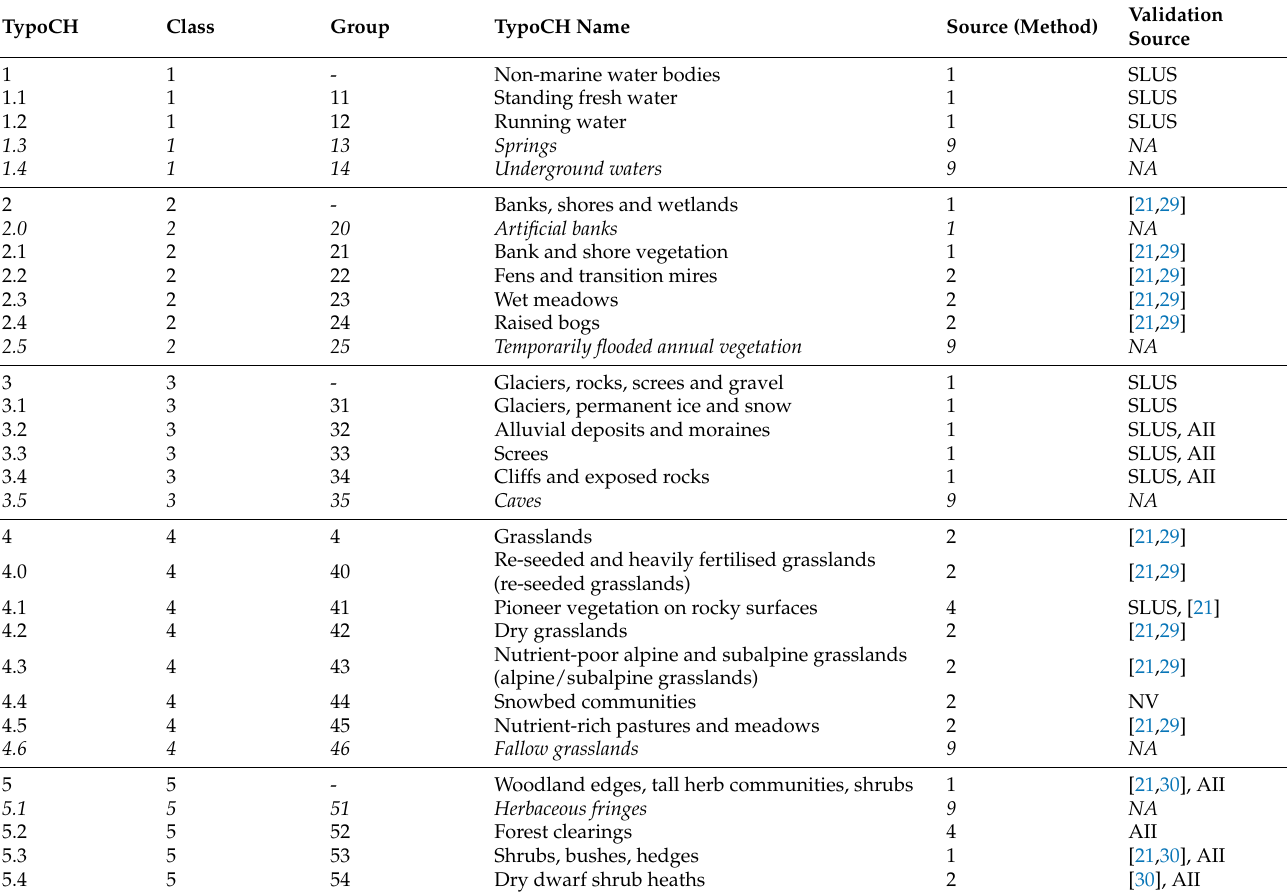
Table 1. TypoCH habitat groups at the second level and the method used to determine their distribu- tion. Method types are (1) the TLM Landcover; (2) habitat distribution models targeting specifically TypoCH habitat types; (3) combination of existing species distribution models; and (4) classification by rule set. Habitats highlighted in light grey were modelled to the 3rd level with the same method- ology as indicated in the column ‘Source (Method)’. Habitats in italics and with a ‘9 (cid:48) indicated in the Methods column were not modelled in version 1 of the habitat map. The source for validation data is indicated in the final column as detailed in the original publications [29–32]: the Swiss land use statistics (SLUS) [5], Delarze distribution maps [21], manual aerial image interpretation